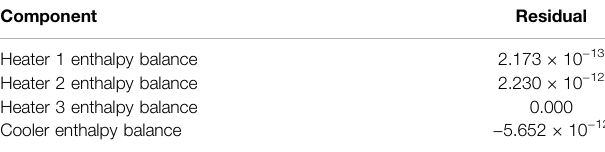
TABLE 10 | Residuals obtained for the enthalpy balance